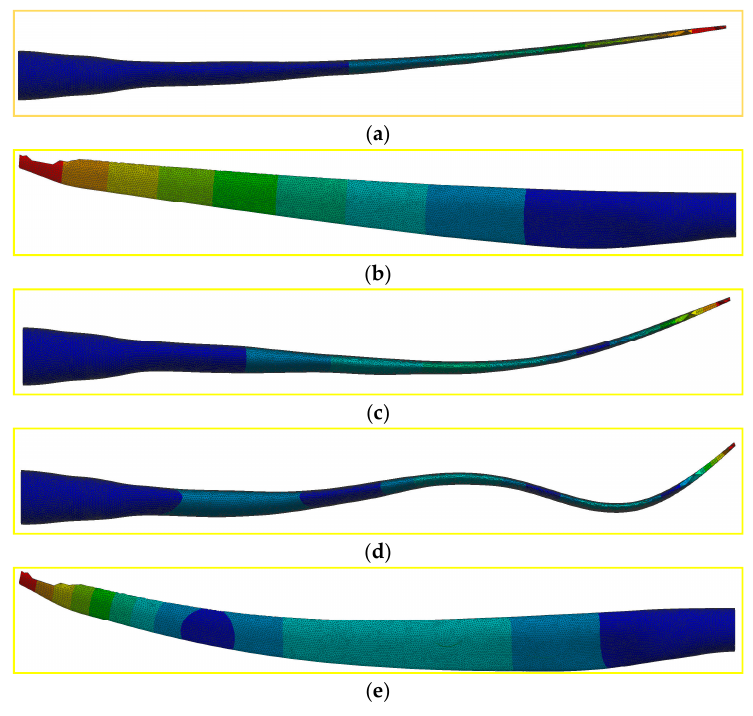
Figure 7. Modal shape of the blade, ( a – d ) the 1st, 2nd and 3rd flapwise modes, and ( b , e ) the 1st and 2nd edgewise modes.